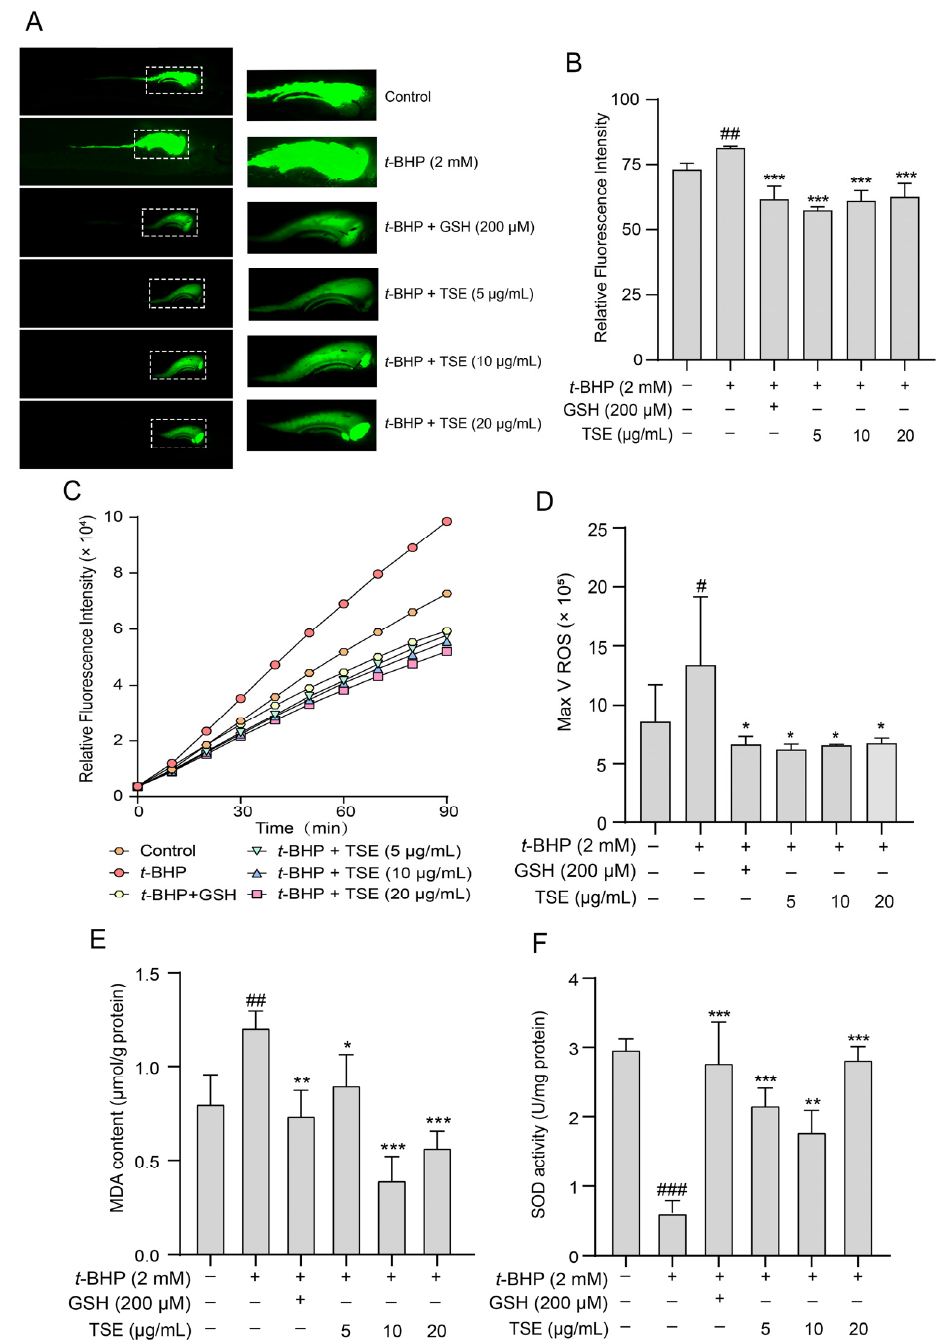
Figure 7. Effect of TSE on t -BHP-induced oxidative stress in zebrafish. ( A ) The fluorescence intensity of DCF in zebrafish co-treated with TSE (5–20 µ g/mL) and t -BHP (2 mM) for 48 h (50 × magnification). n = 5. ( B ) The quantitative analysis of fluorescence intensity in ( A ). ( C ) The ROS generation in zebrafish co-treated with TSE (5–20 µ g/mL) and t -BHP (2 mM) for 48 h was monitored using a fluorescence microplate reader. n = 3. ( D ) The analysis of ROS maximum generation rate in ( C ). ( E , F ) The MDA content and SOD activity in zebrafish co-treated with TSE (5–20 µ g/mL) and t -BHP (2 mM) for 48 h. n = 3. GSH (200 µ M) acts as a positive control. Data were expressed as mean ± SD and the statistical differences were analyzed by one-way ANOVA followed by LSD multiple comparisons test (IBM SPSS Statistics 25.0, Armonk, NY, USA). # p < 0.05, ## p < 0.01, ### p < 0.001 vs. the control group. * p < 0.05, ** p < 0.01, *** p < 0.001 vs. t -BHP